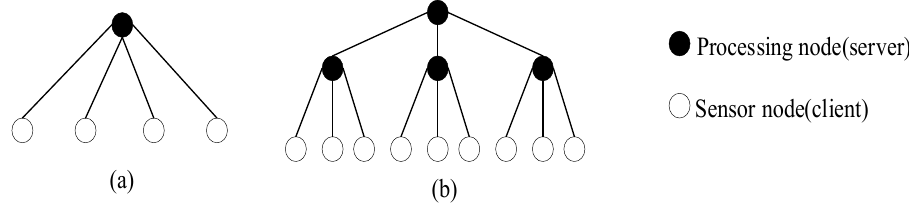
Figure 7. Several client/server models. ( a ) all sensor nodes send data directly to the processing center; ( b ) hierarchical data processing solves transfer problems step by step.